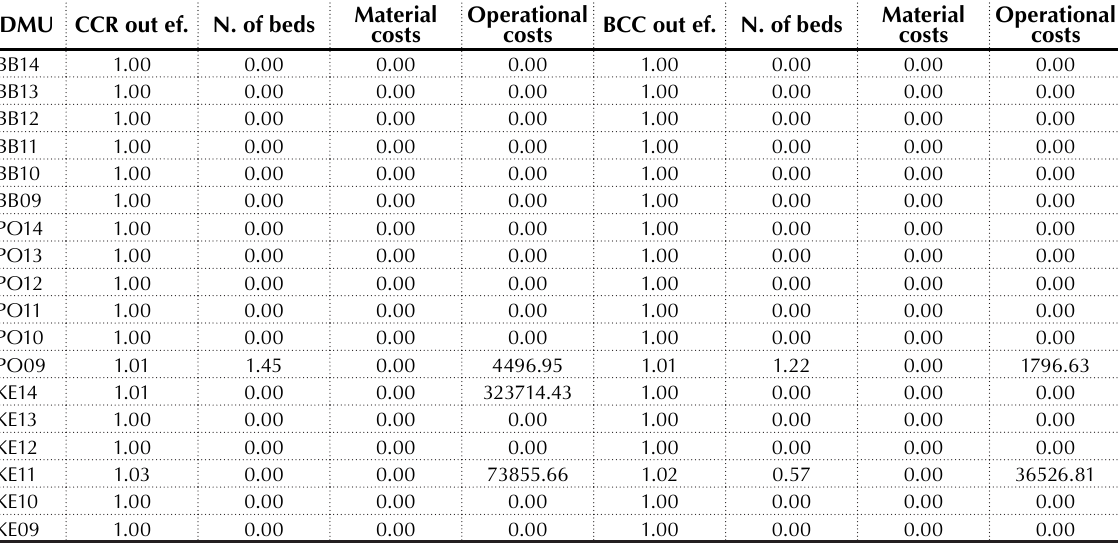
Table 4 (cont.). Efficiency scores and